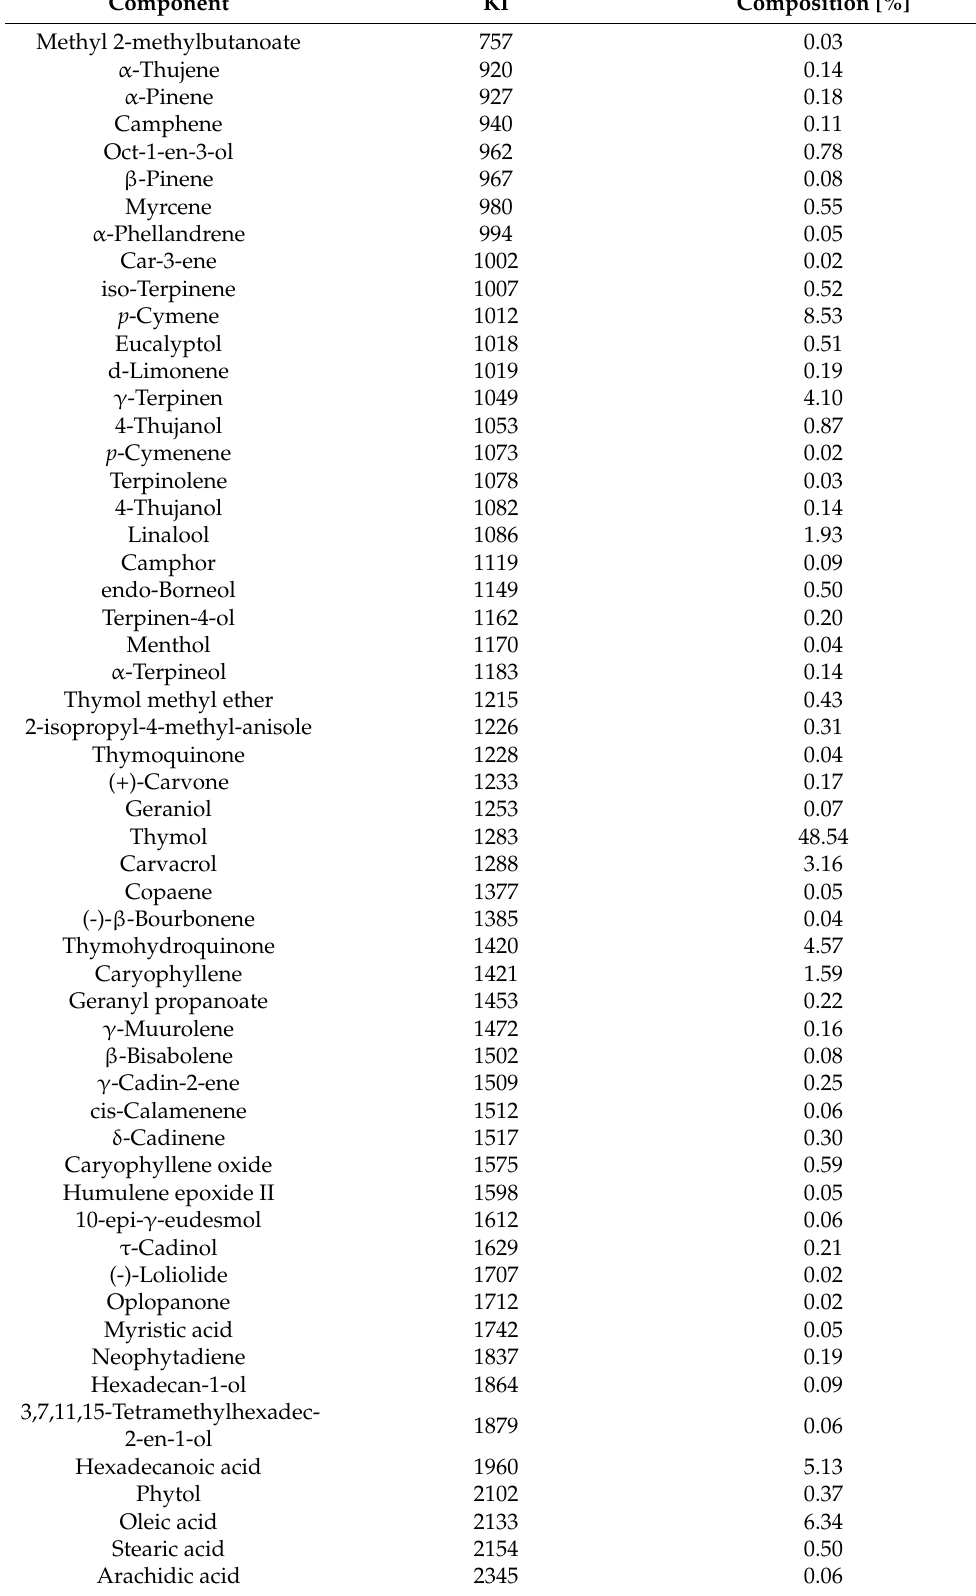
Table 4. Volatile compounds of Thymus vulgaris L. subcritical carbon dioxide